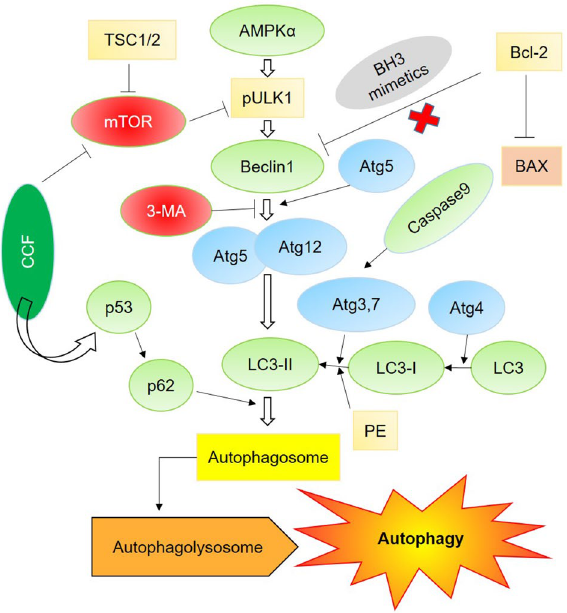
Figure 7. Proposed mode of action of the CCF on the SiHa cells inducing